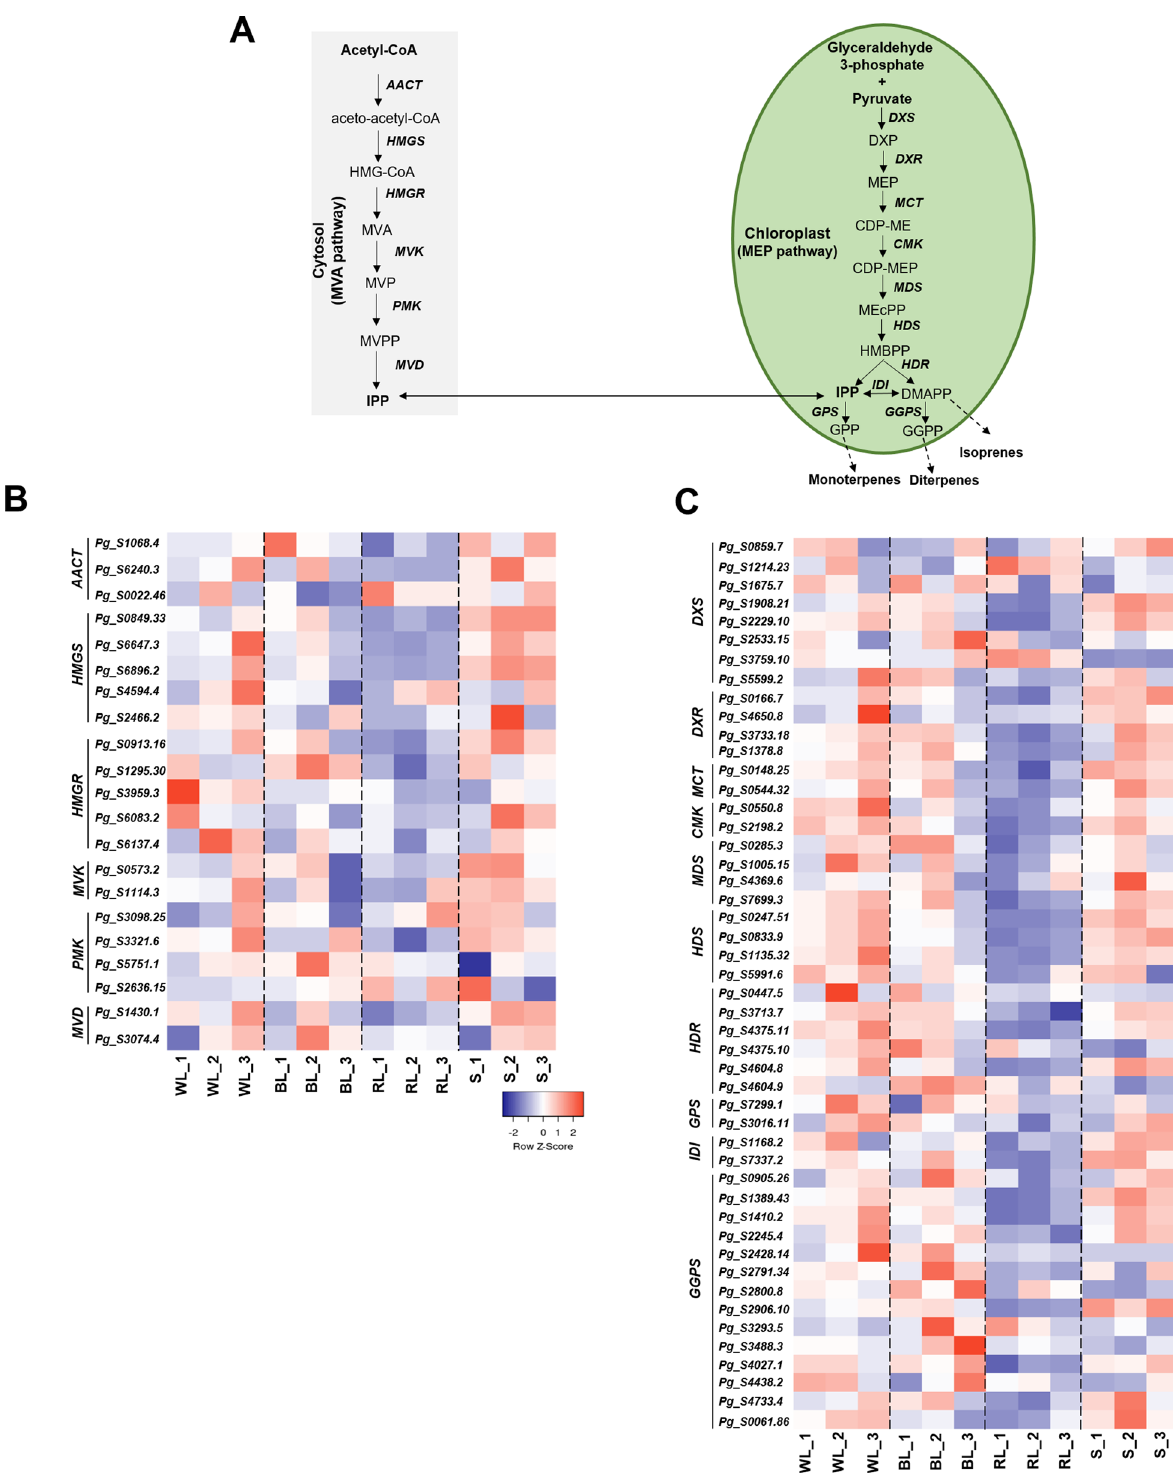
Fig. 2 Expression pattern of isoprenoid biosynthetic pathway genes in ginseng leaf tissues. A Mevalonic acid pathway (MVA) in the cytosol and methylerythritol 4‑phosphate (MEP) pathway in the chloroplast. B Heat map pattern of MVA pathway in white (WL), blue (BL), red (RL), and shade (S) light conditions. C Heat map pattern of MEP pathway genes under various light treatments. The shift from blue to red corresponds to the increasing FPKM